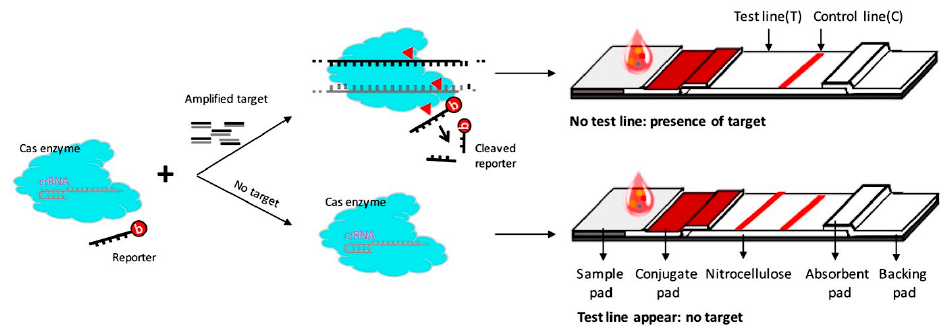
Figure 1. Illustrative principle of CRISPR / Cas–LFB assay. Target DNA from pre-extracted real